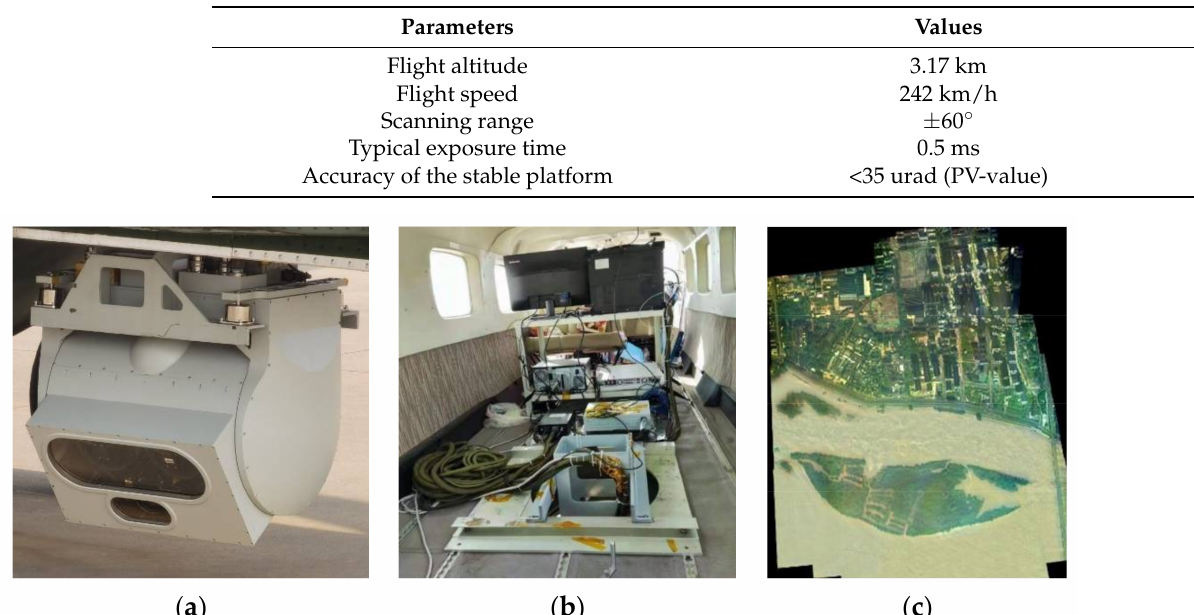
Table 8. Parameters in experiments with the airborne-mapping camera.